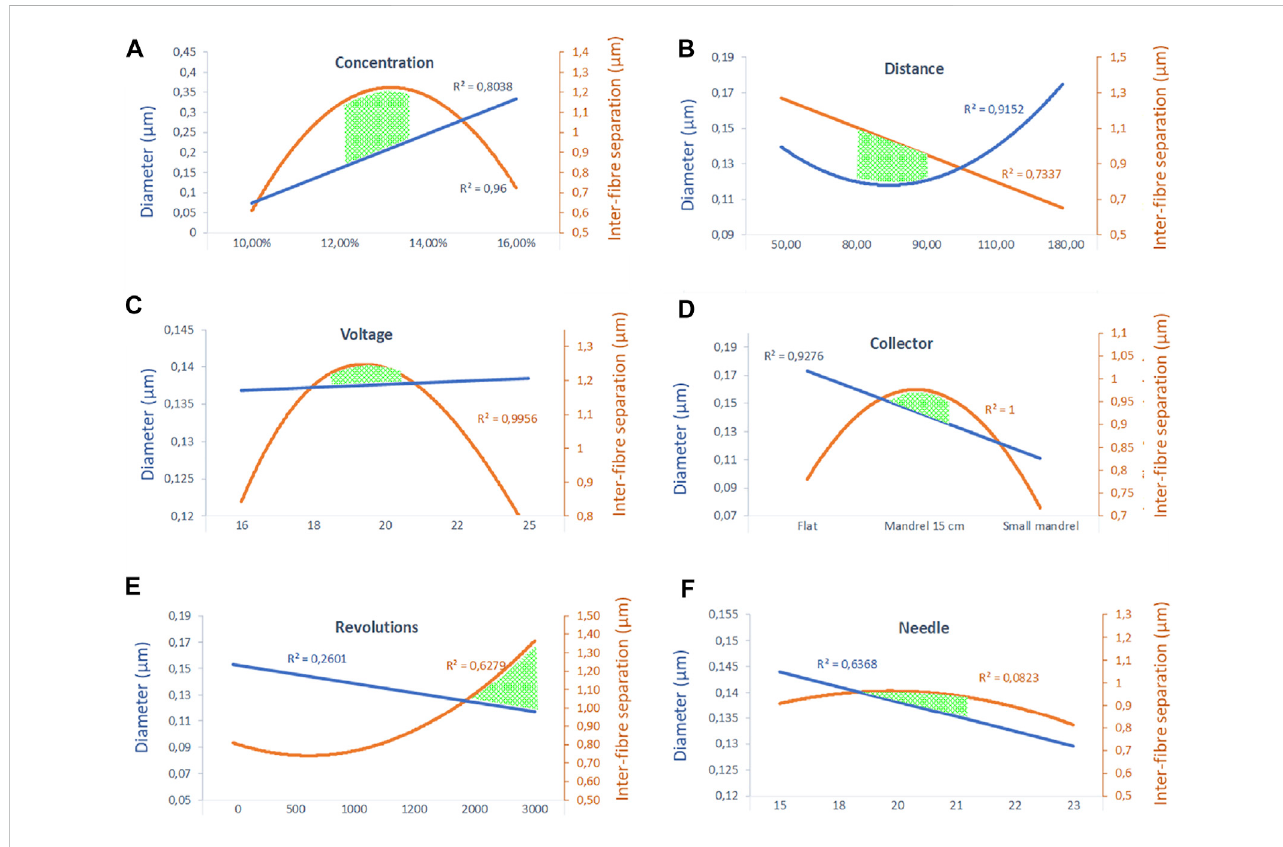
FIGURE 6 Optimisation of the parameters based on low values of diameter of the fi bres and high values of inter- fi bre separation for (A) PVA concentration, (B) distance between the collector and the needle (mm), (C) voltage (kV), (D) type of collector, (E) revolutions (rpm), and (F) gauge of the